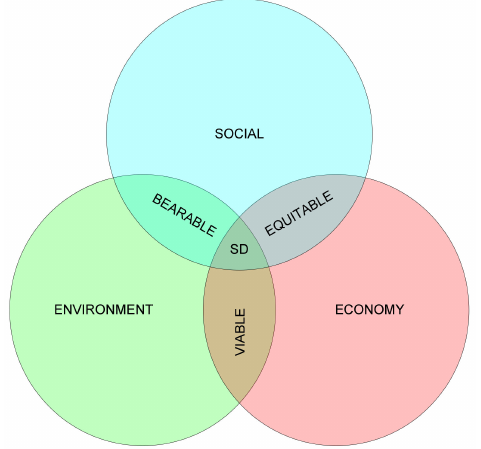
Figure 6. Venn diagram of SD. Adapted from [106].